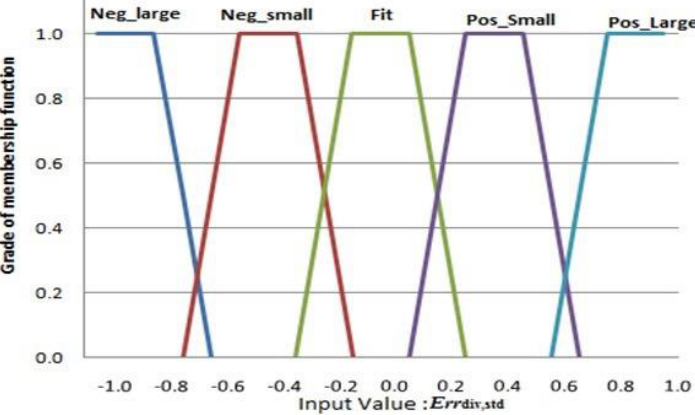
Figure 9. Membership functions of input Err div,std .